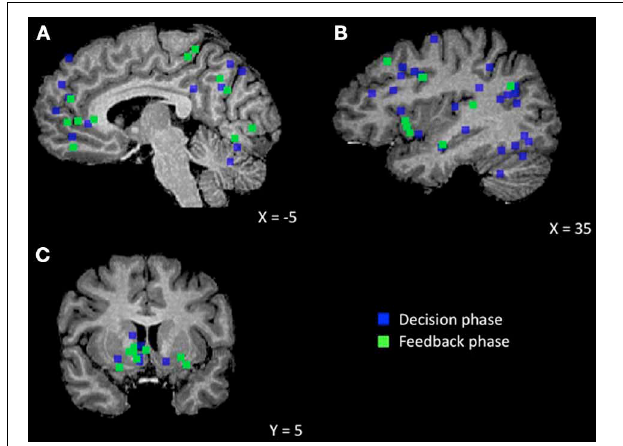
FIGURE 1 | Brain regions showing an effect of human agent compared to non-social control. (A) Medial view displaying MPFC, posterior cingulate/precuneus, cerebellum (B) Lateral view displaying STS, TPJ, DLPFC, IPL, insula, fusiform (C) Coronal view displaying